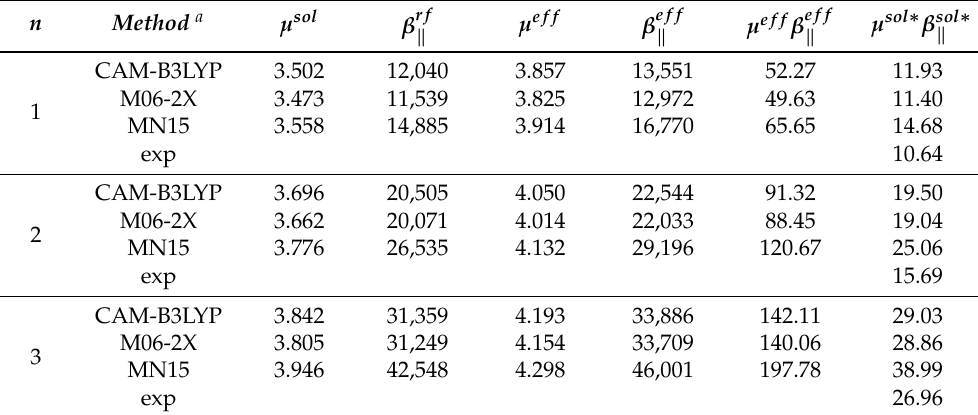
Table 2. Electronic contributions to total solute ( µ sol ) and effective dipole moment ( µ ef f ), average